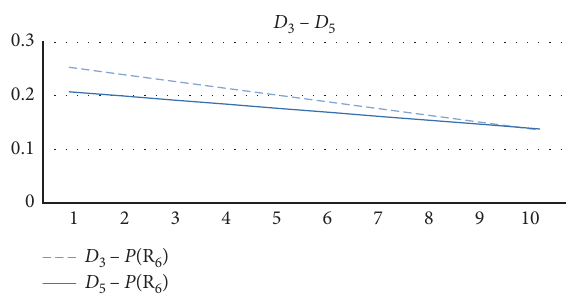
Figure 10: Sensitivity analysis of D